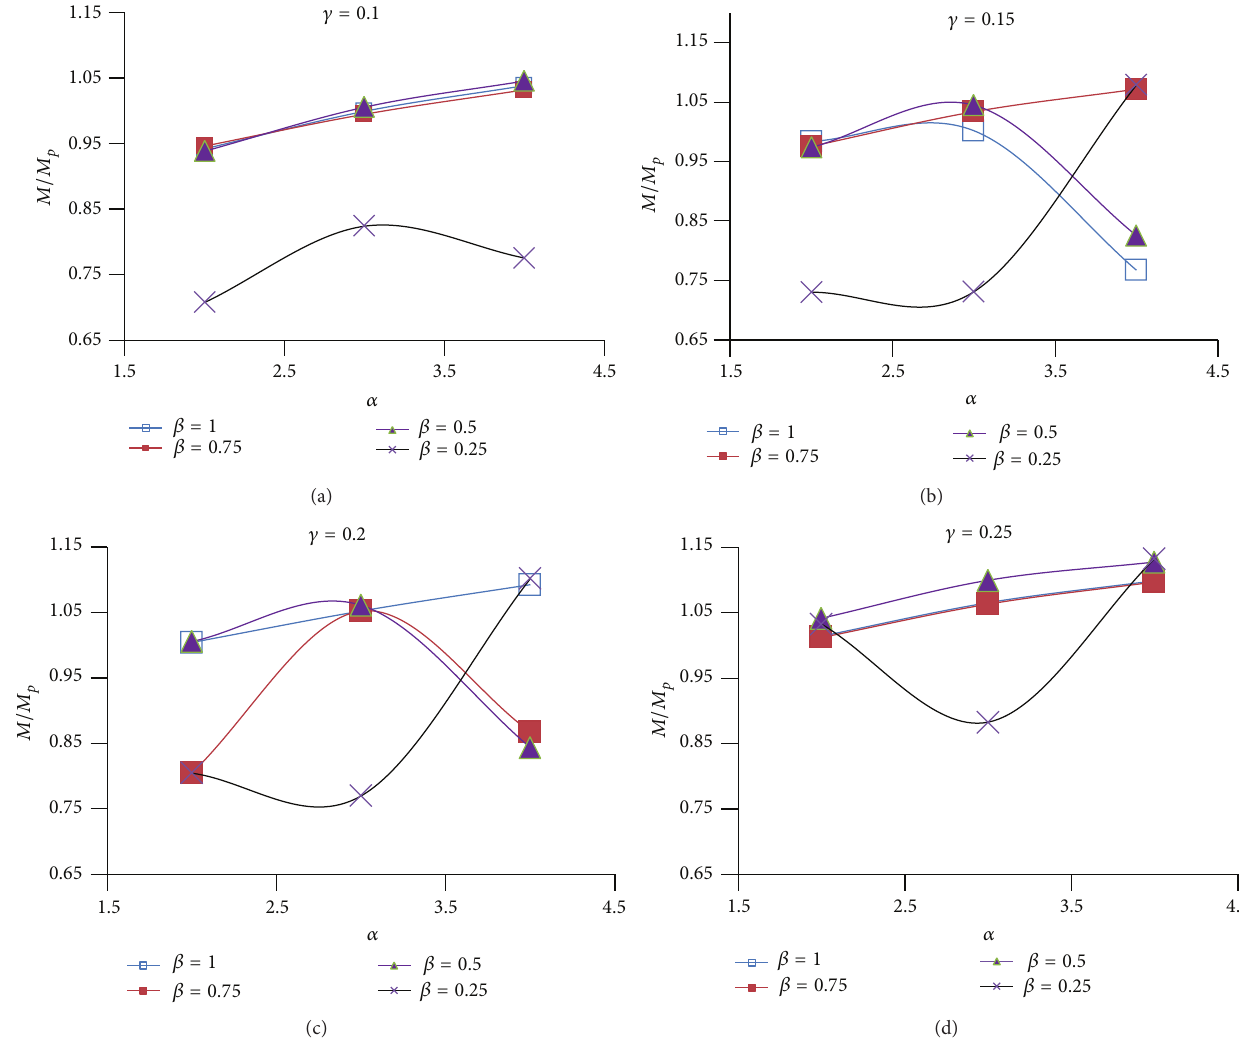
Figure 12: 𝑀/𝑀 𝑃 versus 𝛼 for different values of 𝛽 and 𝛾 for